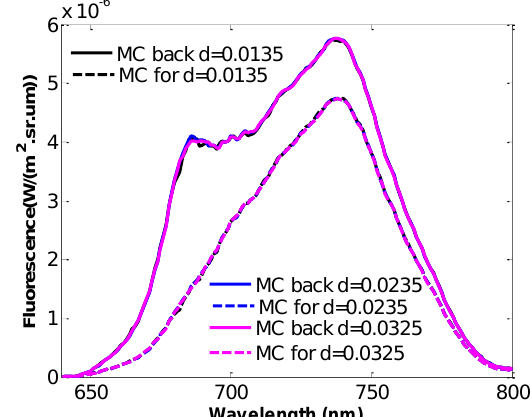
Figure 5. Simulated leaf backward (MC back) and forward (MC for) fluorescence by the MC model with d of 0.0135, 0.0235, and